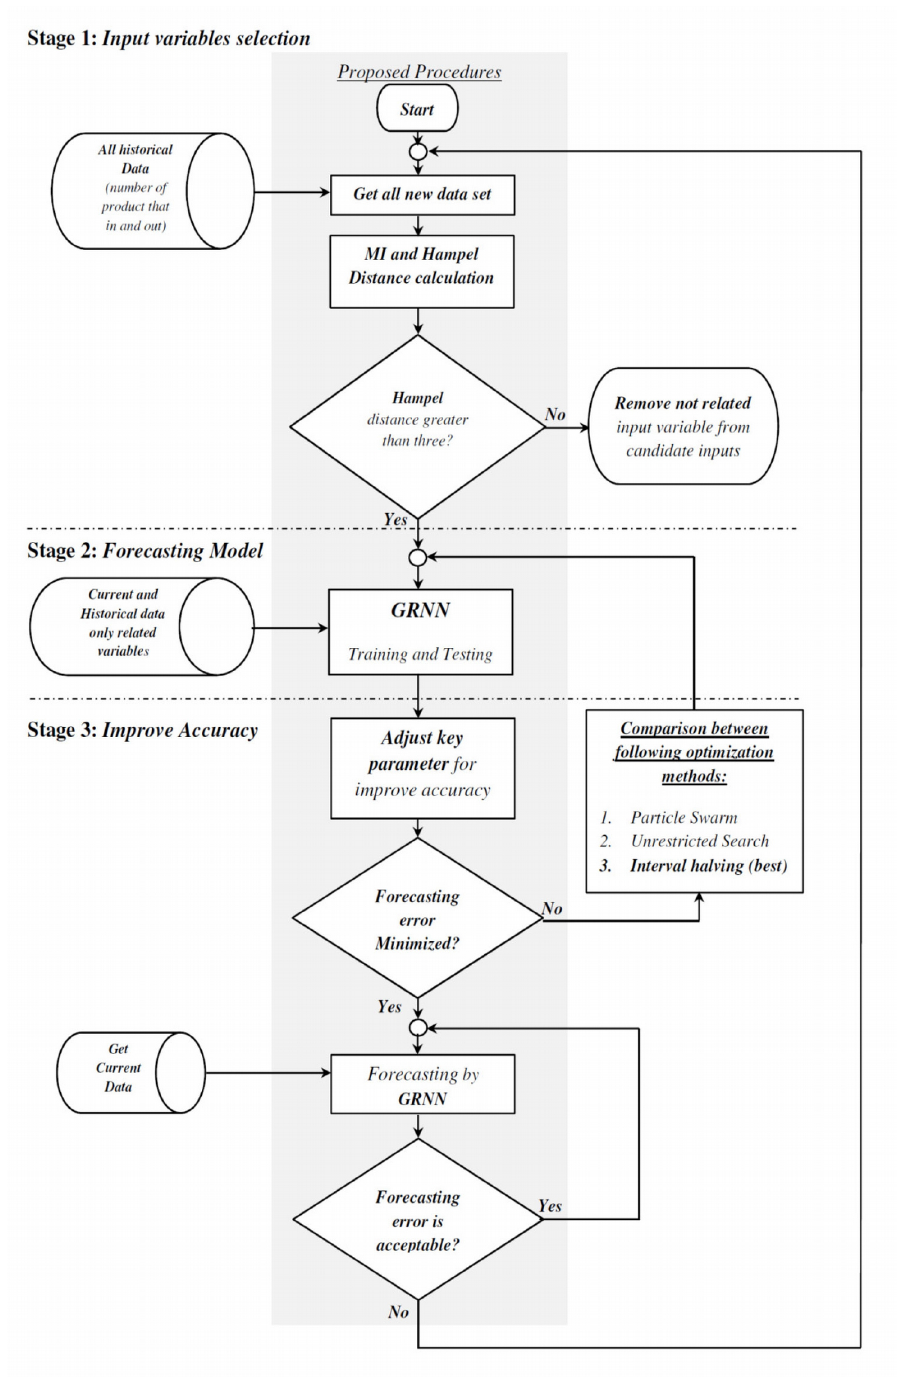
Figure 1. Proposed procedure for development of a forecasting